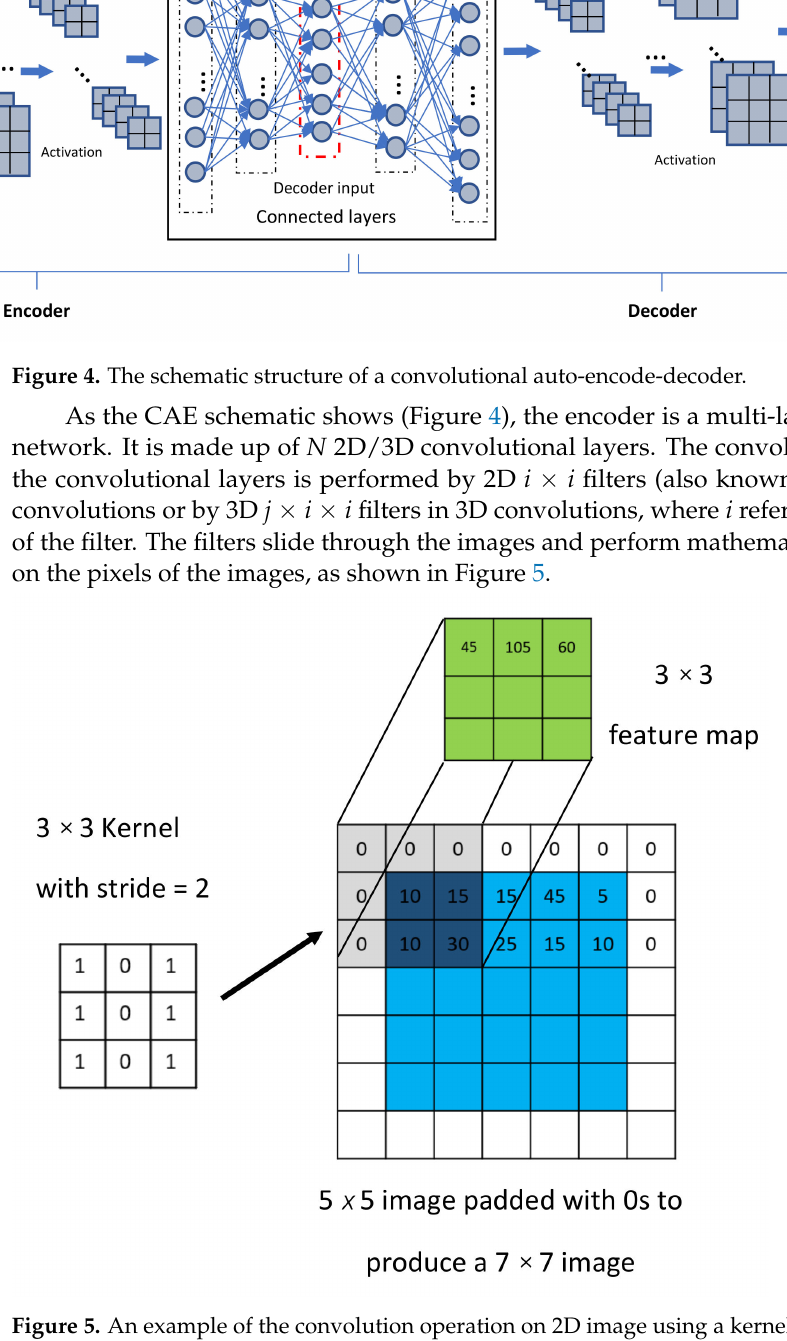
Figure 5. An example of the convolution operation on 2D image using a kernel of 3 ×